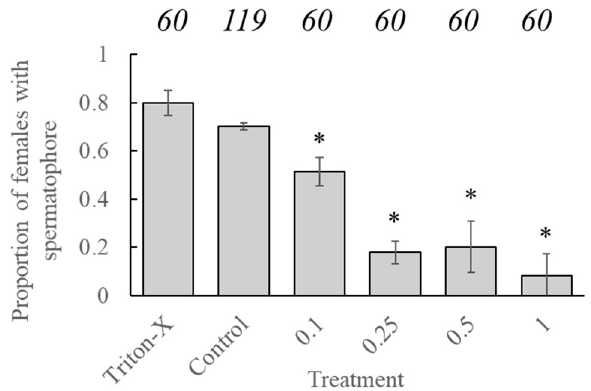
Figure 2. Proportion of adult C. fumiferana females containing a spermatophore after being paired with an adult male of an identical treatment dose. Numerical values above the bars represent the sample sizes (‘n’) for each treatment group. An ‘*’ represents a significant difference in the likelihood of a female containing a spermatophore as compared to the ‘control’ group (Generalized linear model, family = “binomial”, p < 0.05).